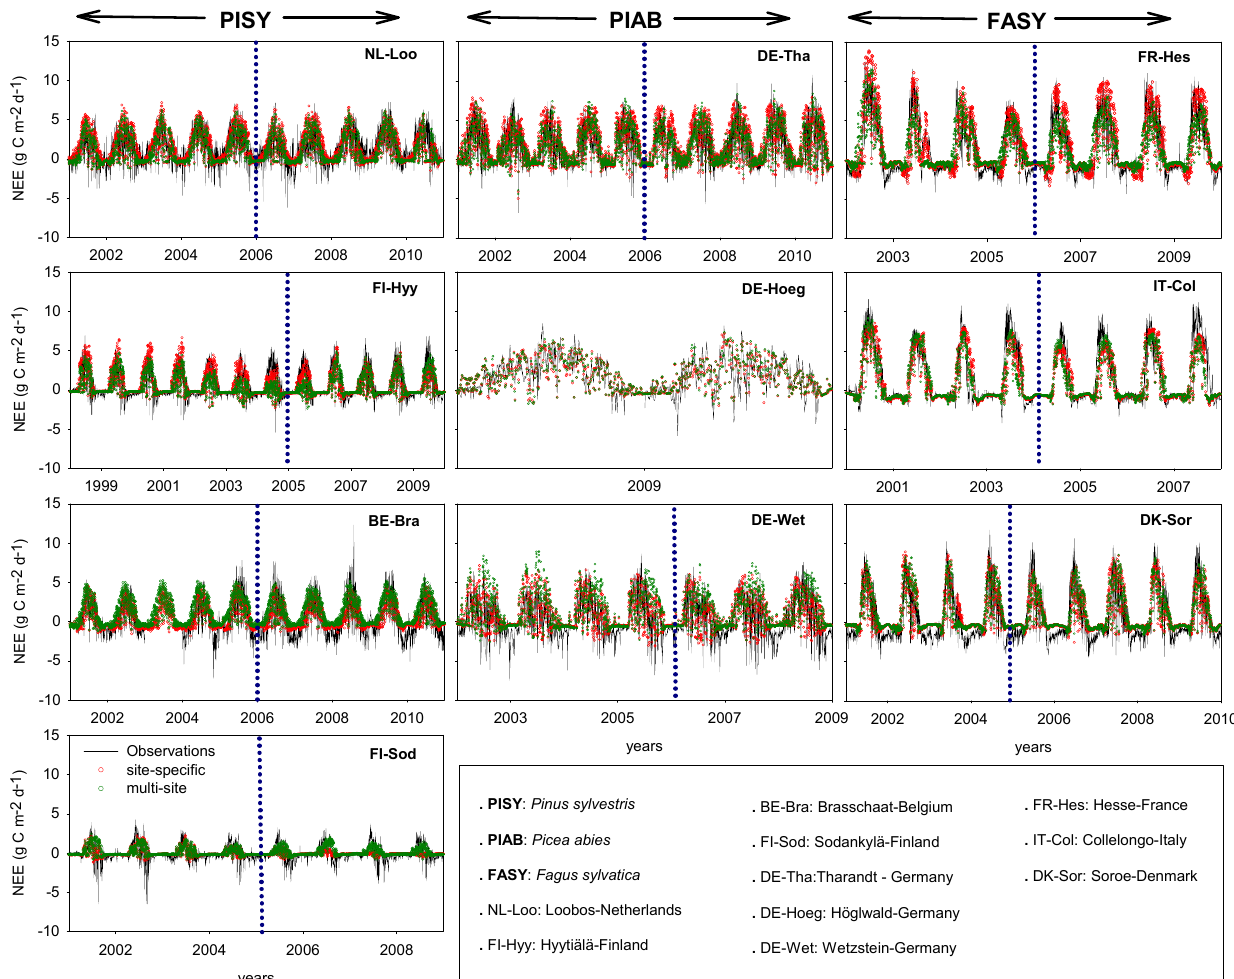
Figure 2. Comparison of daily simulated and measured Net Ecosystem Exchange (NEE) for all investigated sites. The dotted line separates simulations with calibrated (left side) and non-calibrated (right side) parameters. For DE-Hoeg, no evaluation run with a non-calibrated parameter set has been carried